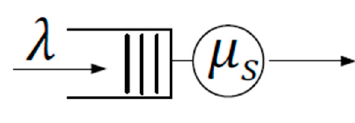
Figure 5. Queuing network OQN.